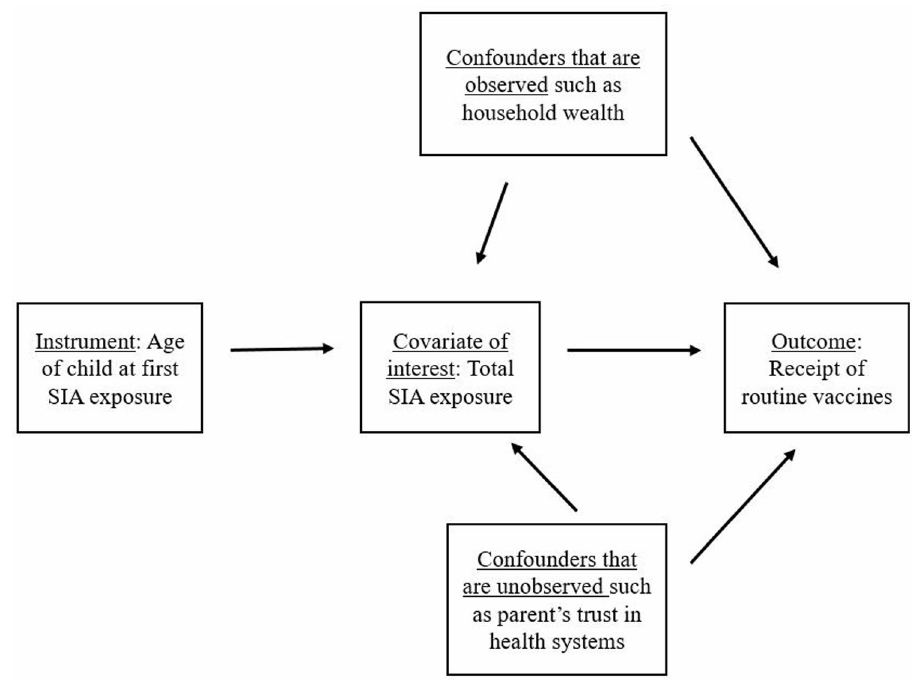
Fig 1. Schematic depiction of the use of an instrumental variable (IV) approach to identify the effect of SIA exposure on routine vaccination.